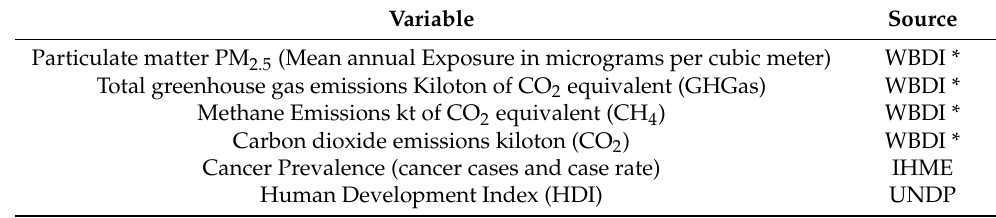
Table 1. Description of variables. Variable